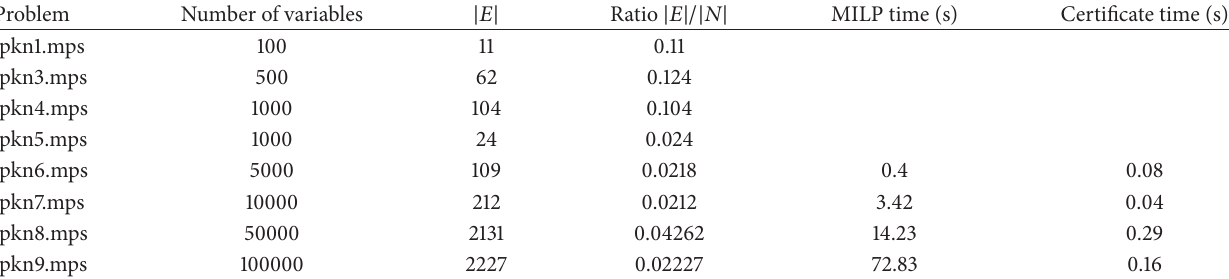
Table 1: Pure integer knapsack problems with nonnegative coefficients.